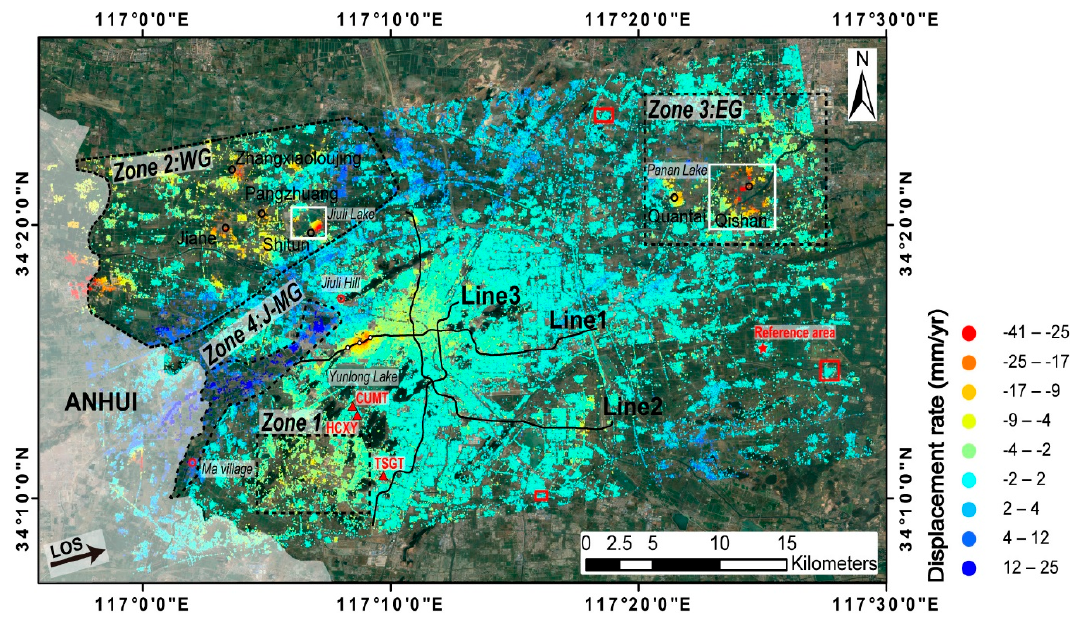
Figure 6. Displacement rate map derived from InSAR time series corrected by Strategy 2, for the entire study area during November 2015 to June 2018. Positive values represent decreases in earth–satellite distance, while negative values represent increases in earth–satellite distance. The subway lines are marked by black lines. Zone 1, Zone 2 WG (the western goaf), Zone 3 EG (the eastern goaf) and Zone 4 J-MG (Jiuli-Ma village goaf) outlined by dashed black lines are the main displacement areas in addition to the subway line buffers. Location of Shitun, Jiahe, Pangzhuang, and Zhangxiaoloujing old coal mines in Zone 2 and of Qishan and Quantai old coal mines in Zone 3 are indicated by black circles. The two white rectangles represent areas which are enlarged and analyzed in detail in Section 5.2. Filled red triangles indicate the locations of the GNSS stations used in this study. Red rectangles indicate zones where no displacement is expected to occur (corresponding to “non-displacement zones” mentioned in the text). The filled red star indicates the location of the reference area. The map conventions are the same as in Figure 4.